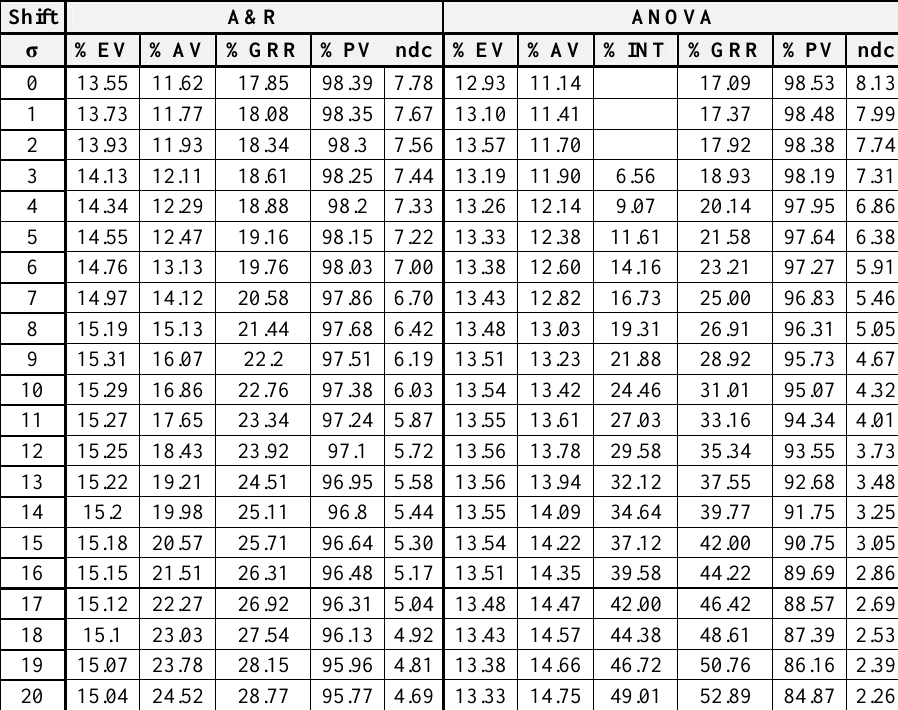
Table 4 Results of Simulation 3 for A&R and ANOVA methods. Shift A&R